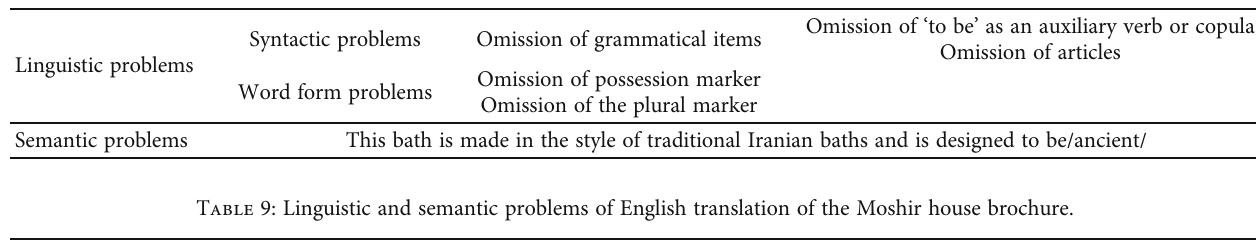
Table 9: Linguistic and semantic problems of English translation of the Moshir house brochure. Linguistic problems